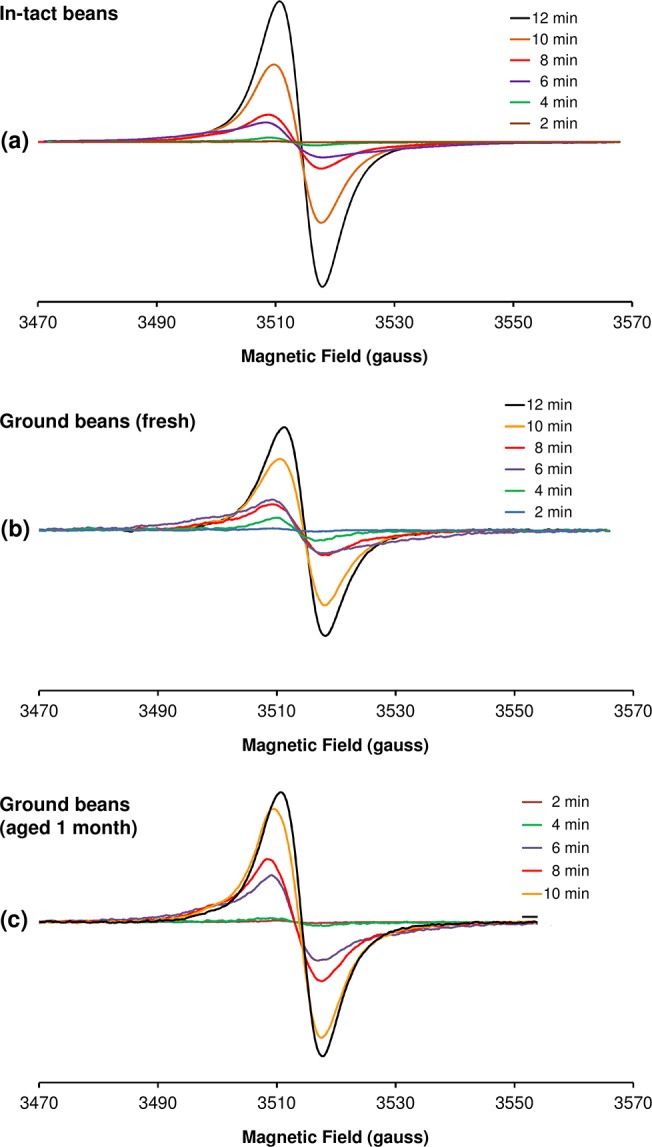
Dependence of the radical EPR spectrum on roasting time in (a) in-tact beans and (b) freshly-ground beans and (c) the same grounds aged 1 month.Data in a represents the average of the double-integrated intensity of EPR spectra obtained from 6 individual beans (S3 Fig) at each roasting time. Experimental conditions: microwave frequency, 9.860 GHz; microwave power, 0.1 mW; magnetic field modulation amplitude, (a) 3 G, (b,c) 1 G; field modulation frequency, 100 kHz; receiver time constant, 164 ms; receiver gain, (a) 60 dB, (b,c) 66 dB; sweep rate, 4 G/s; averages, 1. The intensity in b-c is directly comparable, whereas the intensity in a is not directly comparable with b-c.